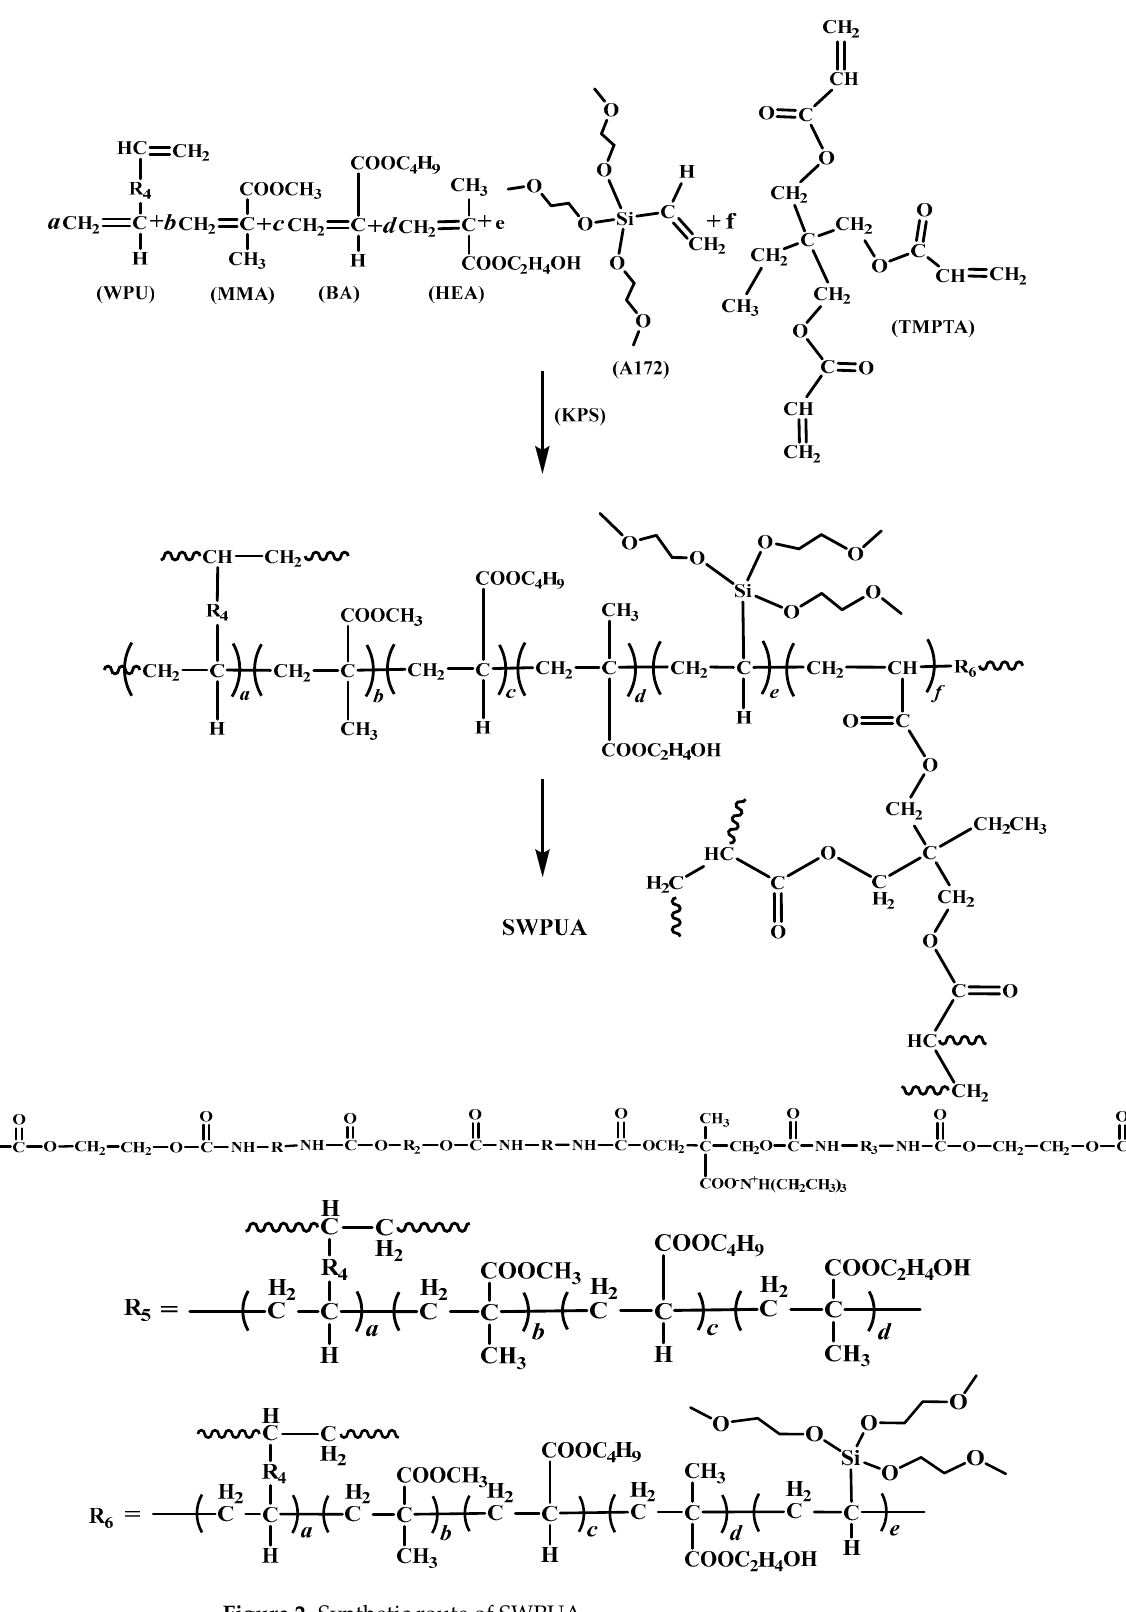
Figure 2. Synthetic route of SWPUA .